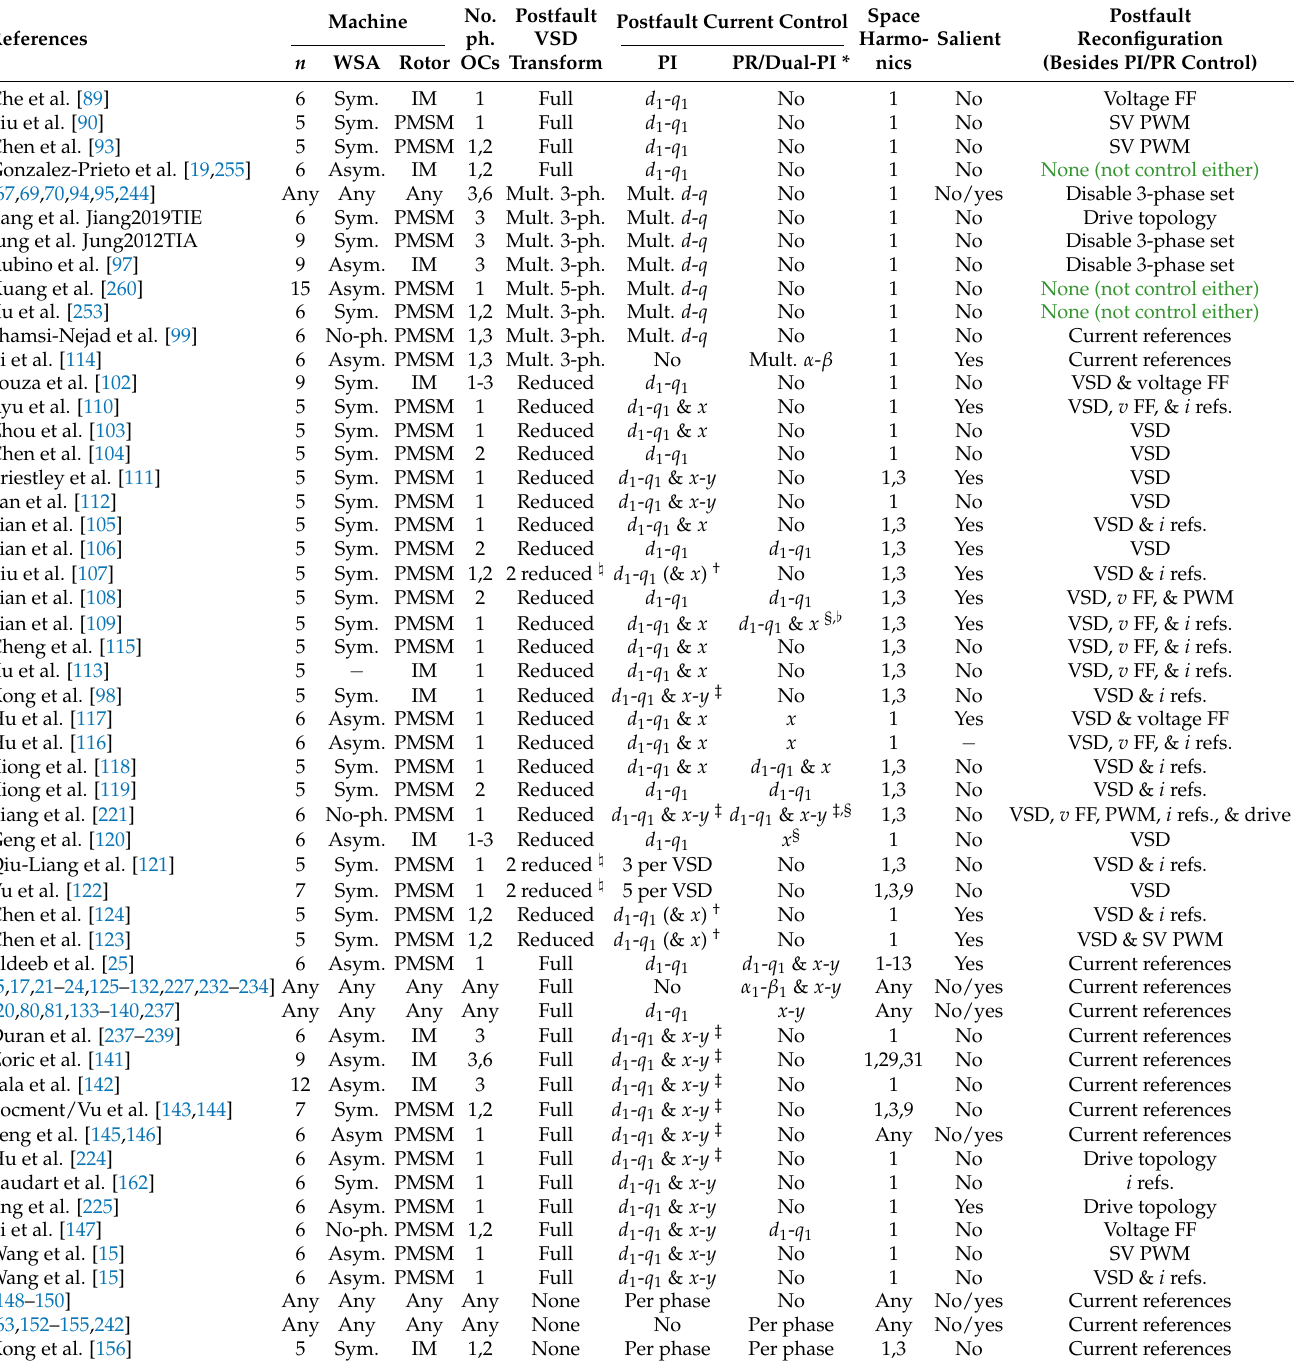
Table 7. Methods based on RFOC with current PR or d - q PI control for tolerating phase OCs (Section 3.4.1) in multiphase applications in the